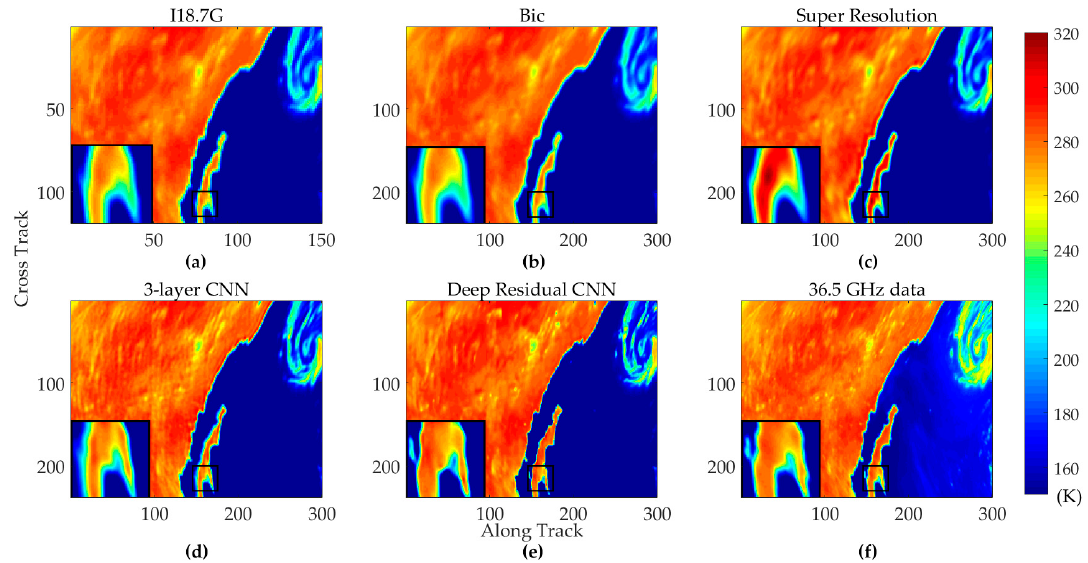
Figure 11. Tested results for the 18.7 GHz data. ( a ) The sub-sampled 18.7 GHz data I 18.7 G ; ( b ) The bicubic interpolation result; ( c ) The super resolution result; ( d ) The 3-layer CNN result; ( e ) The deep residual CNN result; ( f ) The 36.5 GHz data.